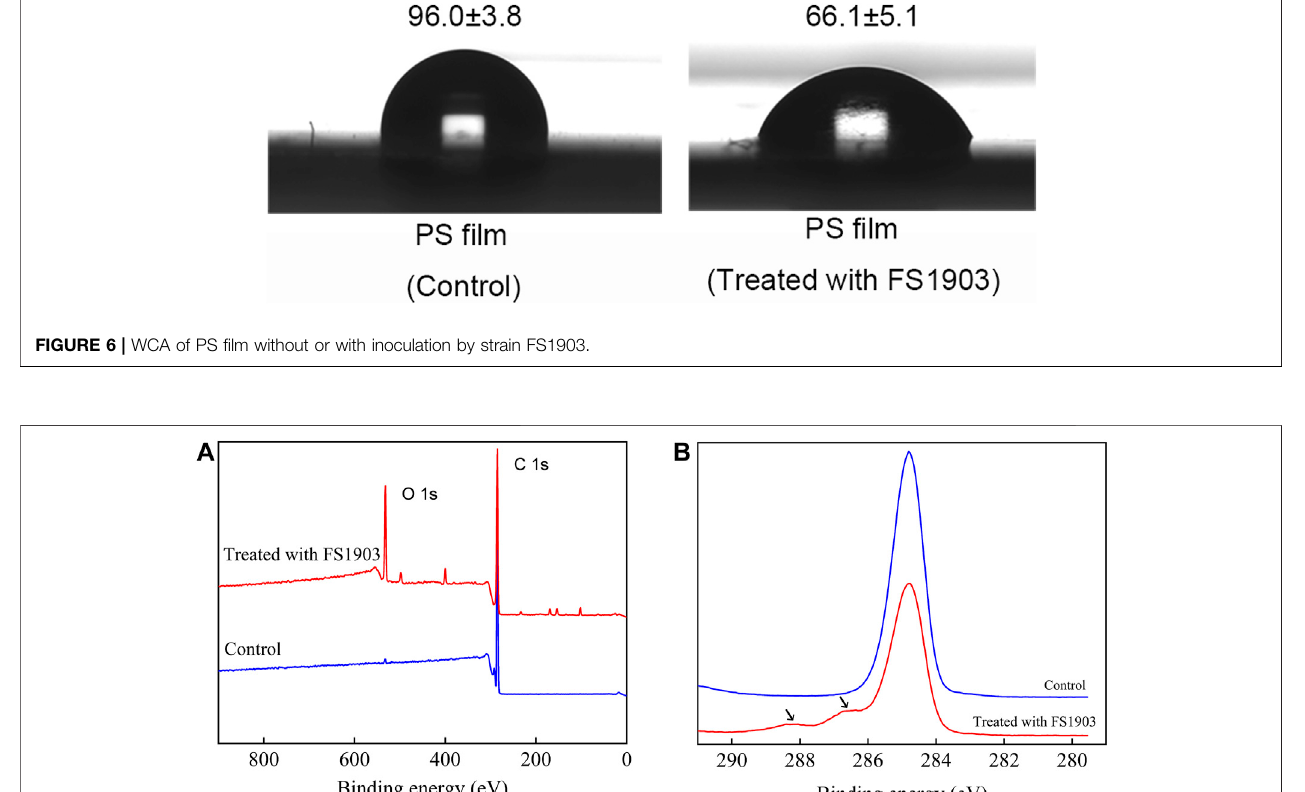
Frontiers in Bioengineering and Biotechnology |